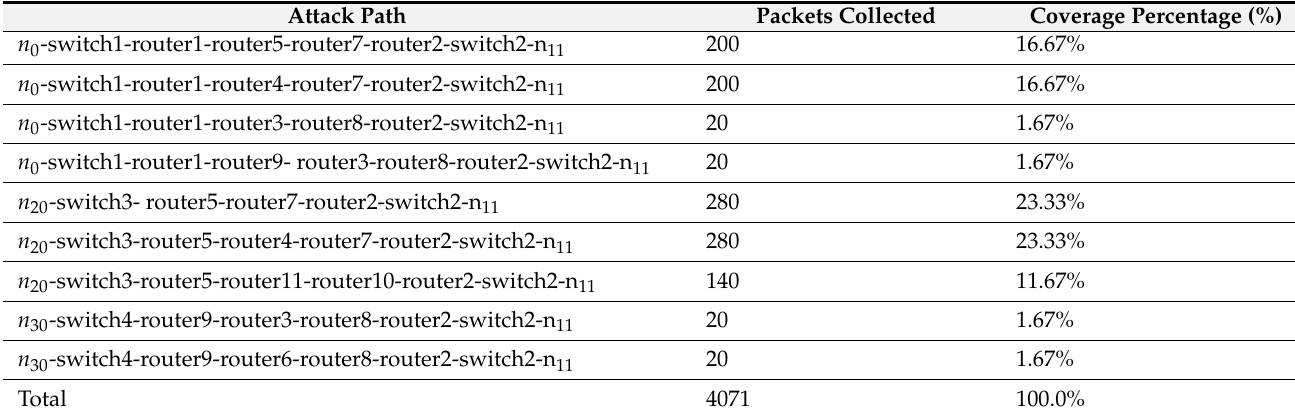
Table 6. Possible attack path of DDoS attacks (number of nodes = 64, array ( x , y ), w = x *). Attack Path Packets